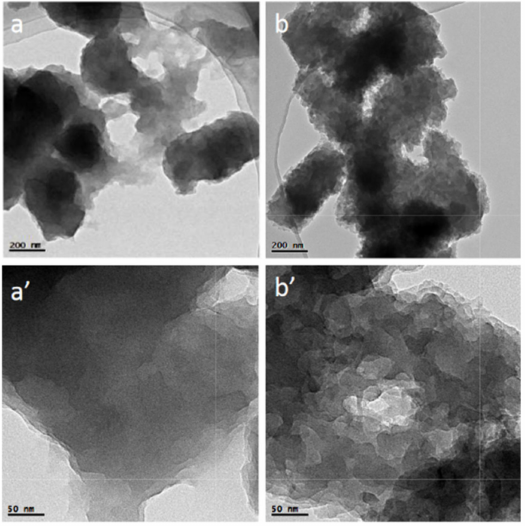
Figure 10. TEM images of ( a , a ’) PANI and ( b , b ’) FLN/PANI [118], reprinted with permission from Elsevier.